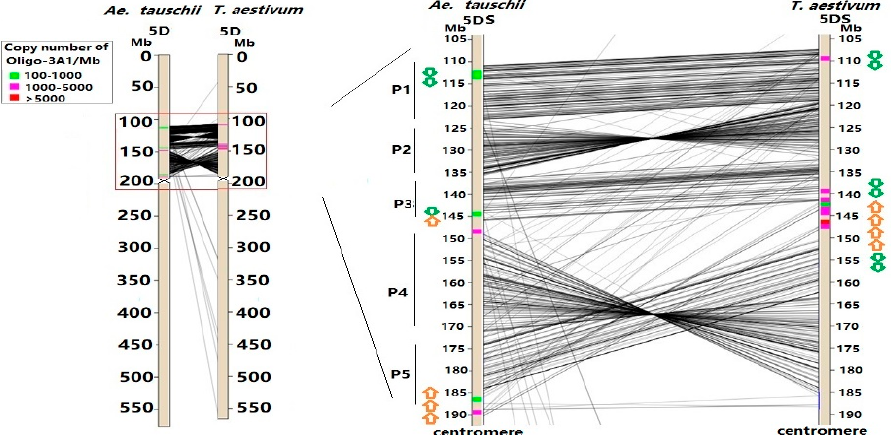
Figure 7. The genome collinearity of pericentromeric regions of chromosome 5D between Ae. tauschii and wheat Chinese Spring (CS).